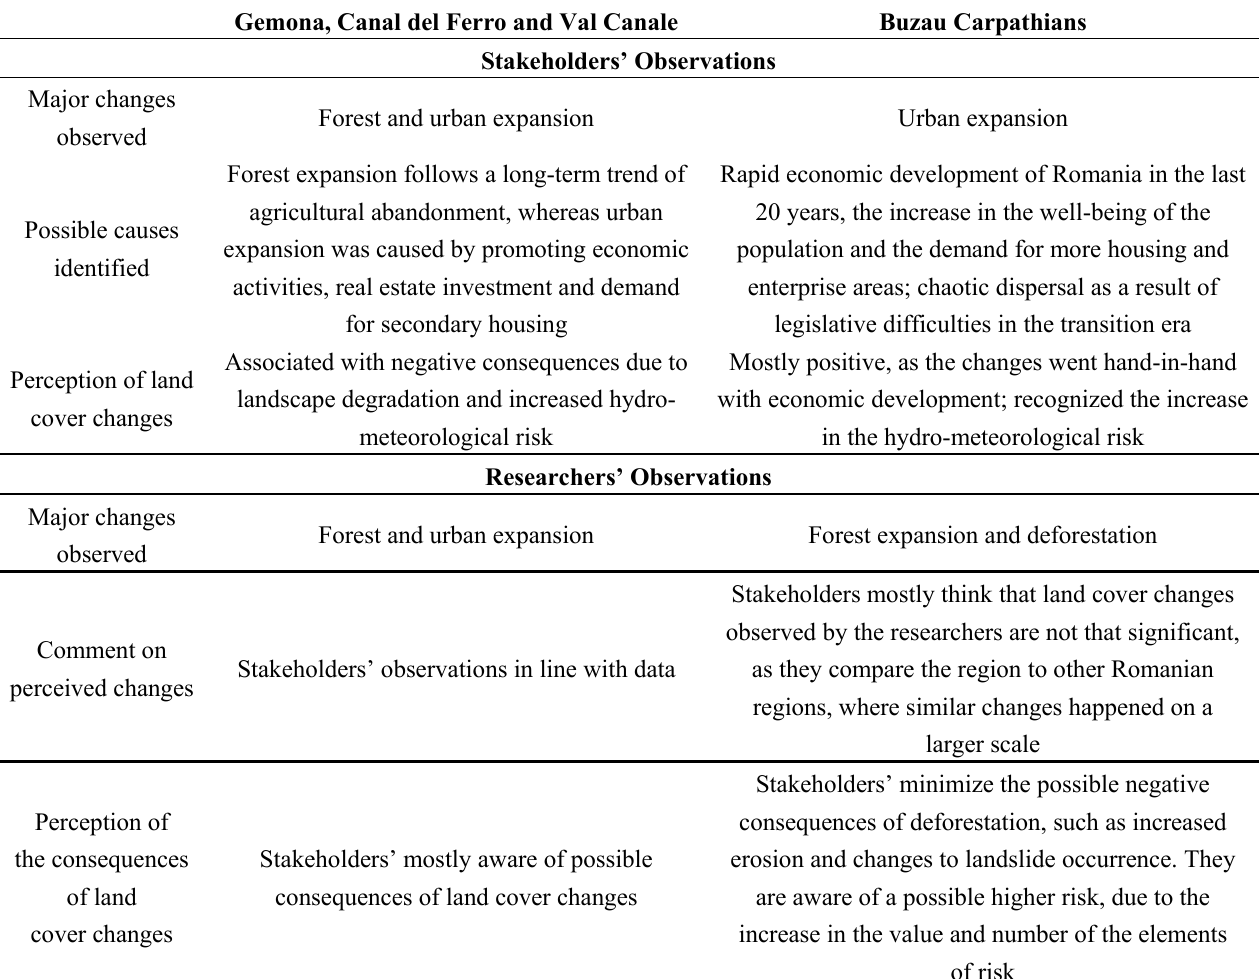
Table 8. Summary of stakeholders’ perception of land cover changes in both